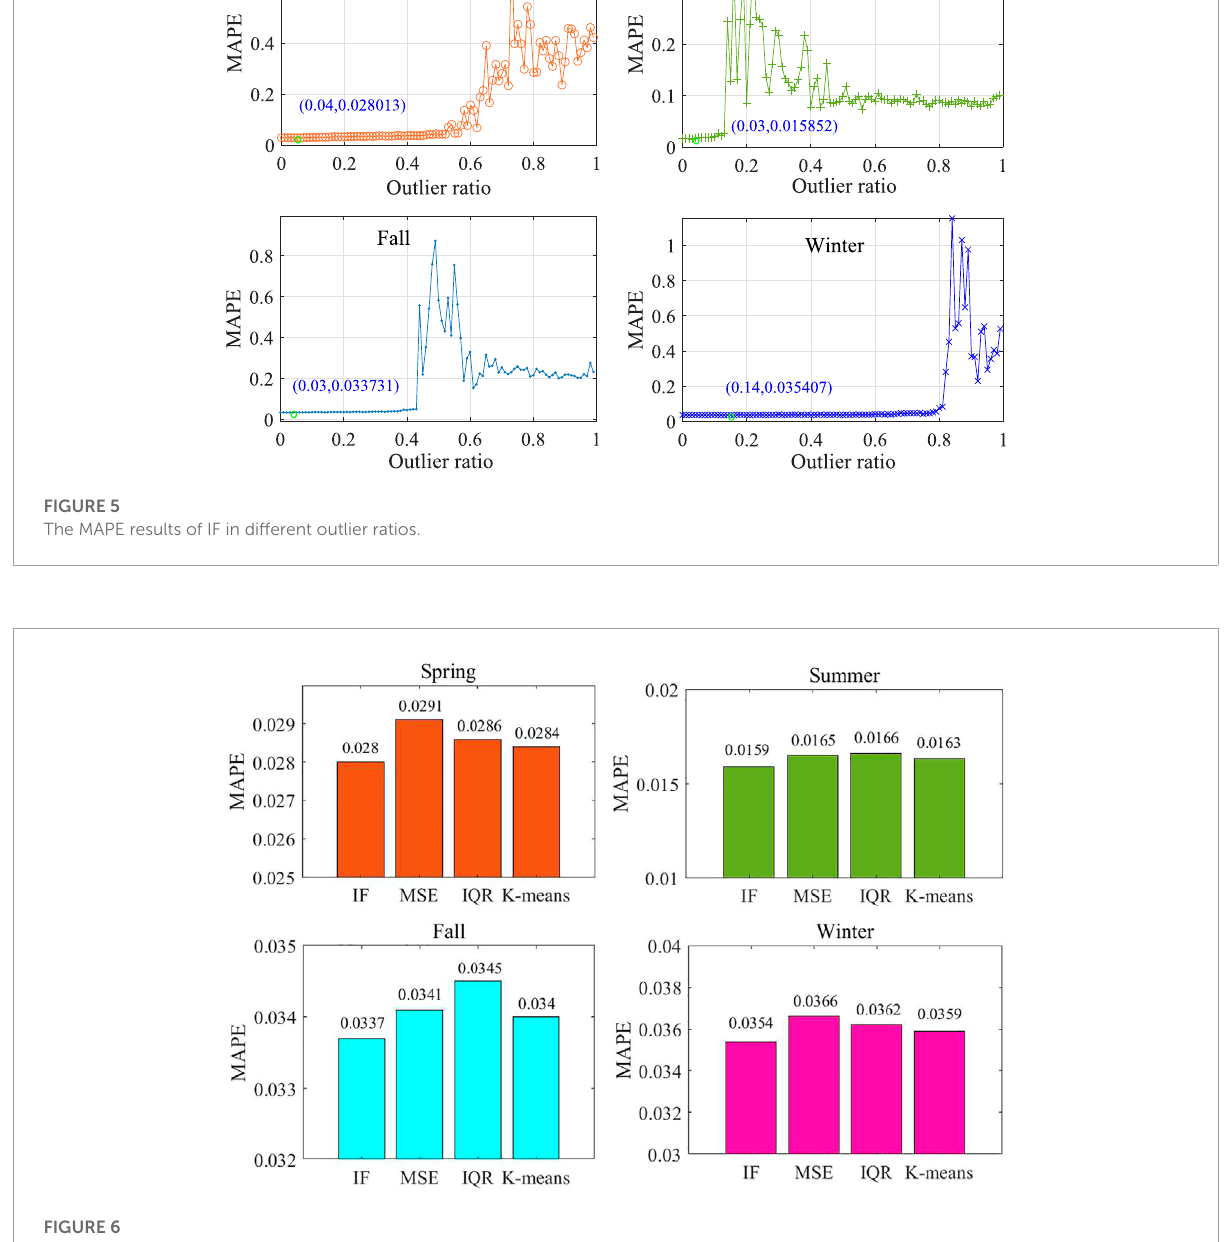
where p and q are a scaling variable and a translation variable, respectively. g ( t ) denotes the signal decomposed by the wavelet. Daubechies function is used as the mother wavelet function ϕ (⋅) in this